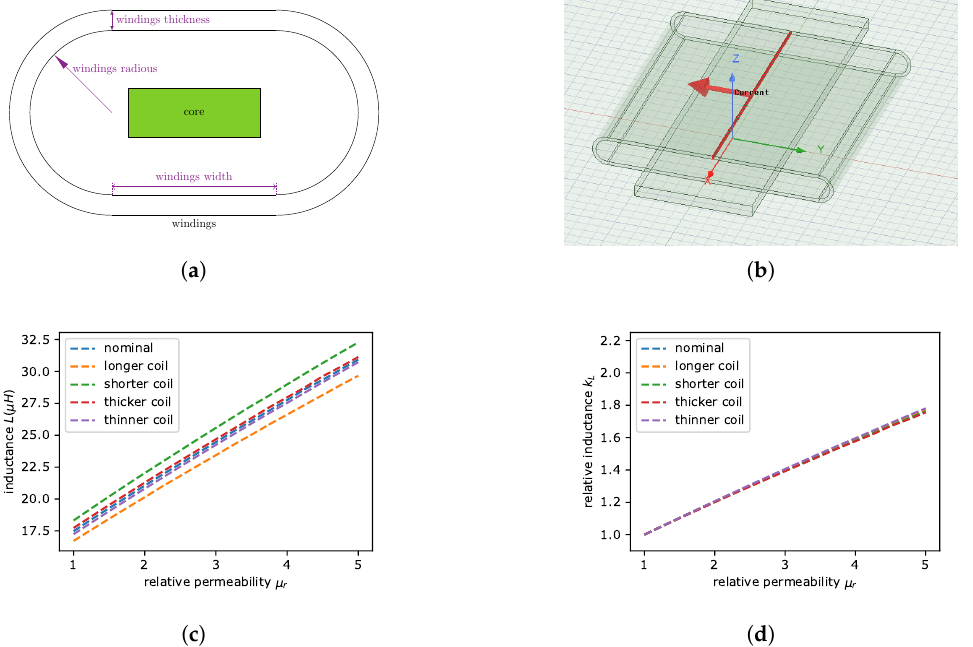
Figure 2. The cross section of coil windings and beam (core) ( a ). The coil model. ( b ) The absolute value of inductance for coil with varying permeability of beam and various geometry ( c ). The relative value of inductance for analogous example ( d ).